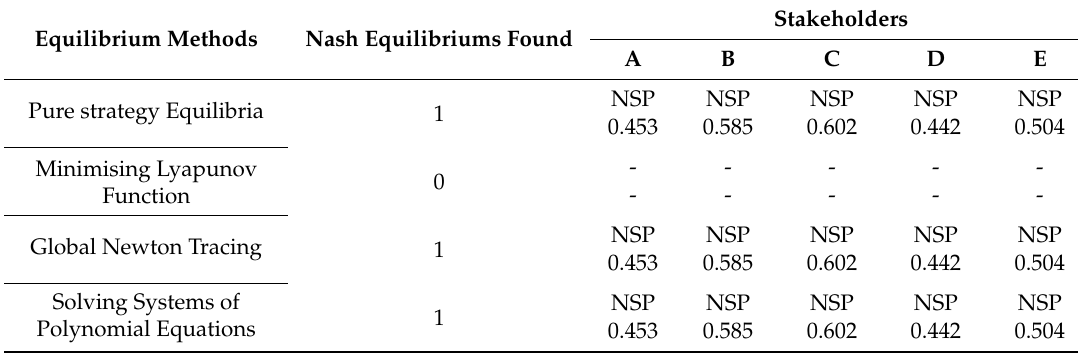
Table 12. Nash Equilibriums for the combined preferences of